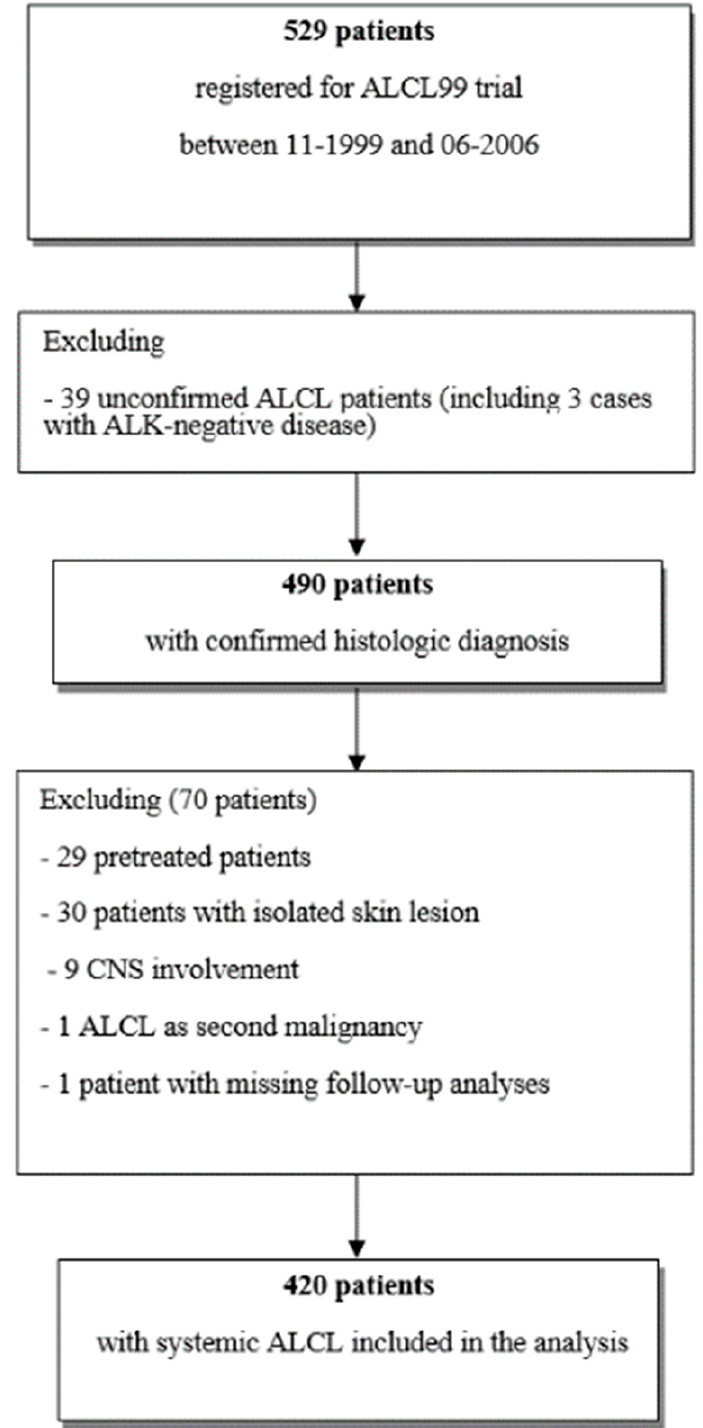
Figure 1. Flow chart of anaplastic large cell lymphoma (ALCL) patients included in the analysis.